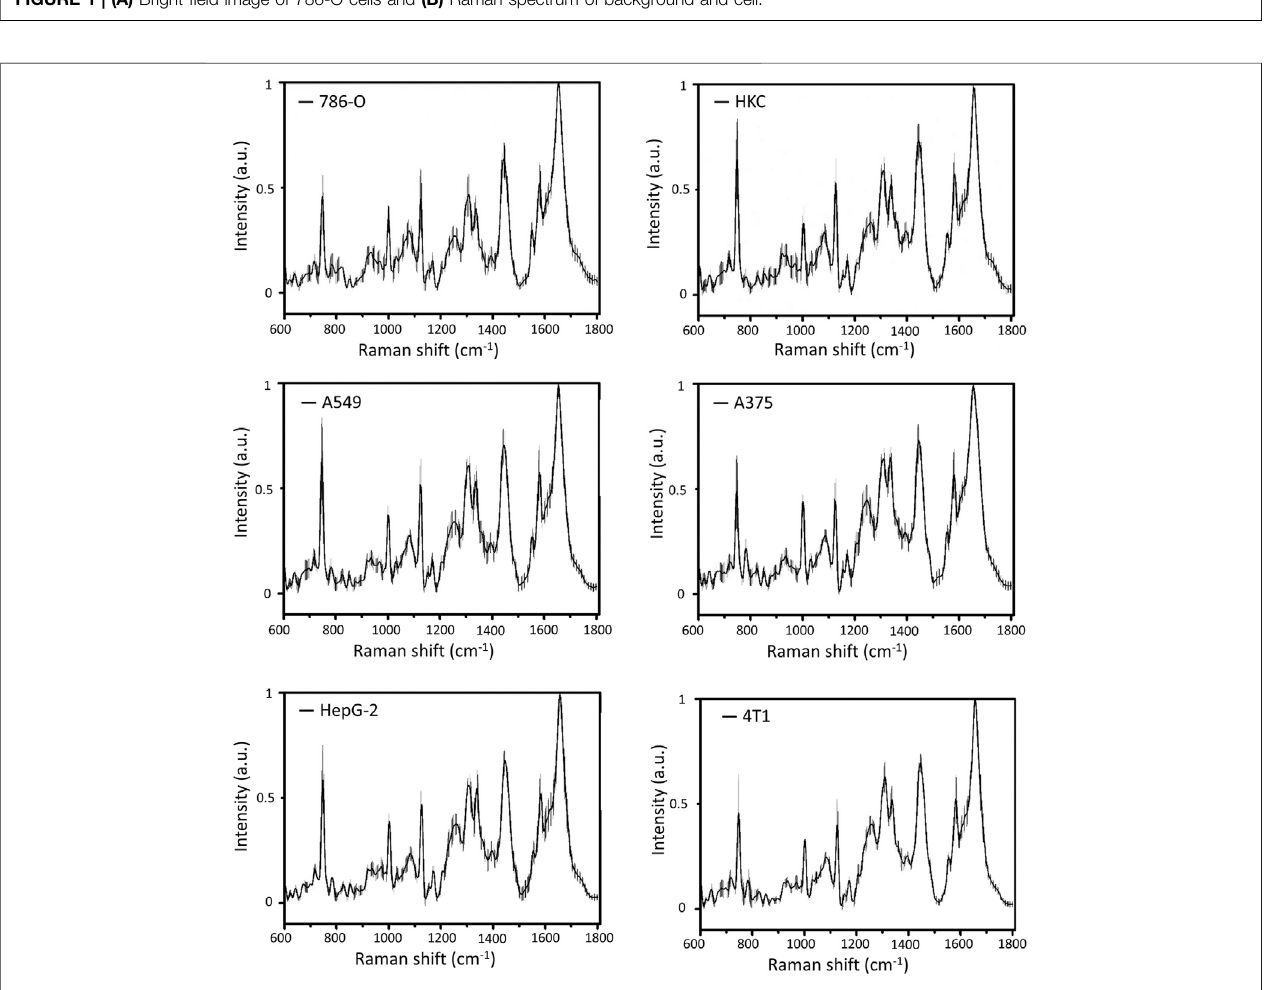
Frontiers in Chemistry |